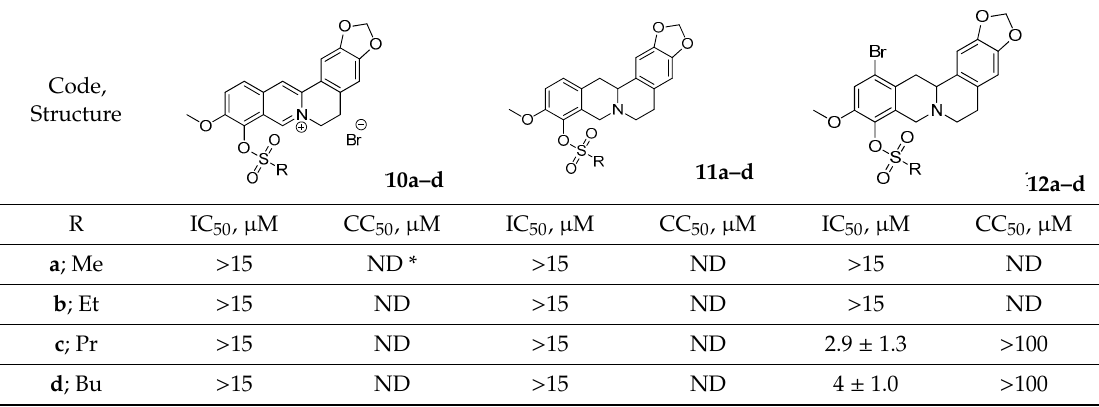
Table 2. Tdp 1 inhibiting activity (IC 50 ) of sulfonate berberine derivatives with polyfluoroaromatic substituents and their cytotoxicity (CC 50 ) in HeLa cells. Furamidine was used as a positive control (IC 50 = 1.2 ± 0.3 µM). Code, structure